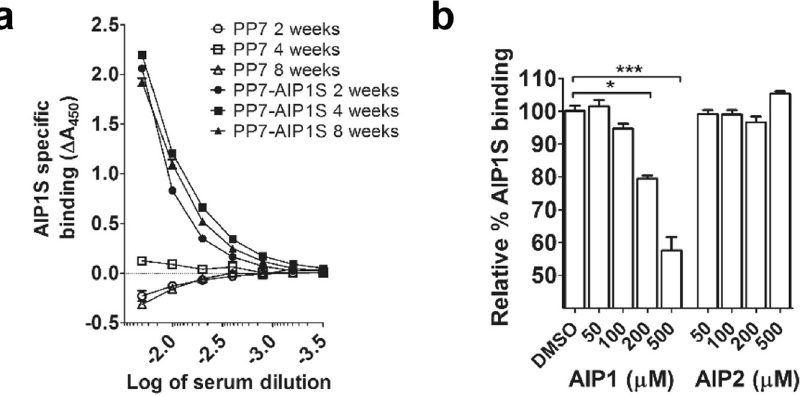
Figure 2. PP7-AIP1S vaccination induces antibodies which recognize soluble AIP1. BALB/c mice were vaccinated twice (i.m.) at 4 week intervals with 10 µ g of PP7-AIP1S or PP7 wild-type (control). ( a ) Serum was collected at the indicated time points after the second vaccination. Serum was then pooled (n = 3 mice per group), treated as described in Materials and Methods, and relative binding to PP7-AIP1S determined by ELISA. ( b ) PP7-AIP1S antiserum collected at eight weeks after the second vaccination was prepared as in ( a ), and relative AIP1S binding determined in the presence and absence of the indicated concentrations of AIP1 or AIP2 (n = 3 mice per group; duplicate experiments performed in triplicate). Data are mean ± s.e.m. Kruskal- Wallis ANOVA p < 0.0001 with Dunn’s post-test: * p < 0.05; *** p <